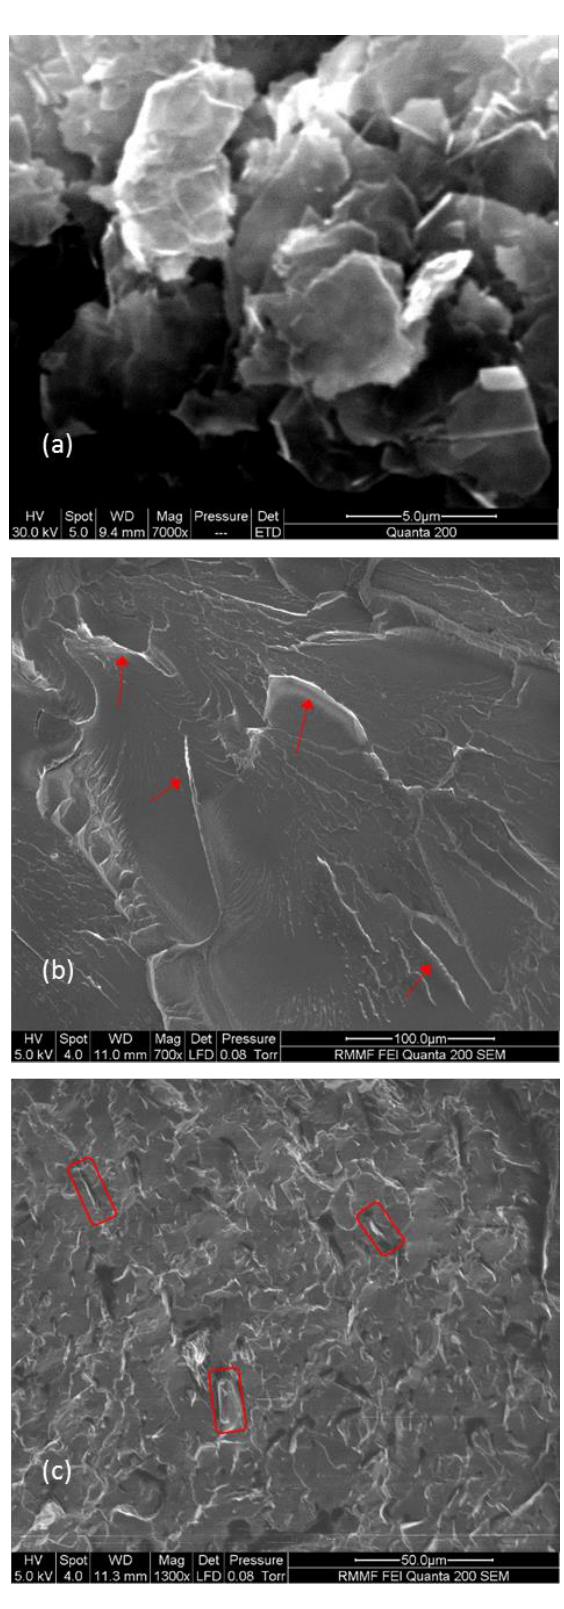
Figure 3. SEM images of ( a ) graphene nanoplatelets, ( b ) fractured cross section of virgin PBAT, and ( c ) fractured surface of PABT nanocomposite with 3 wt % GNPs.